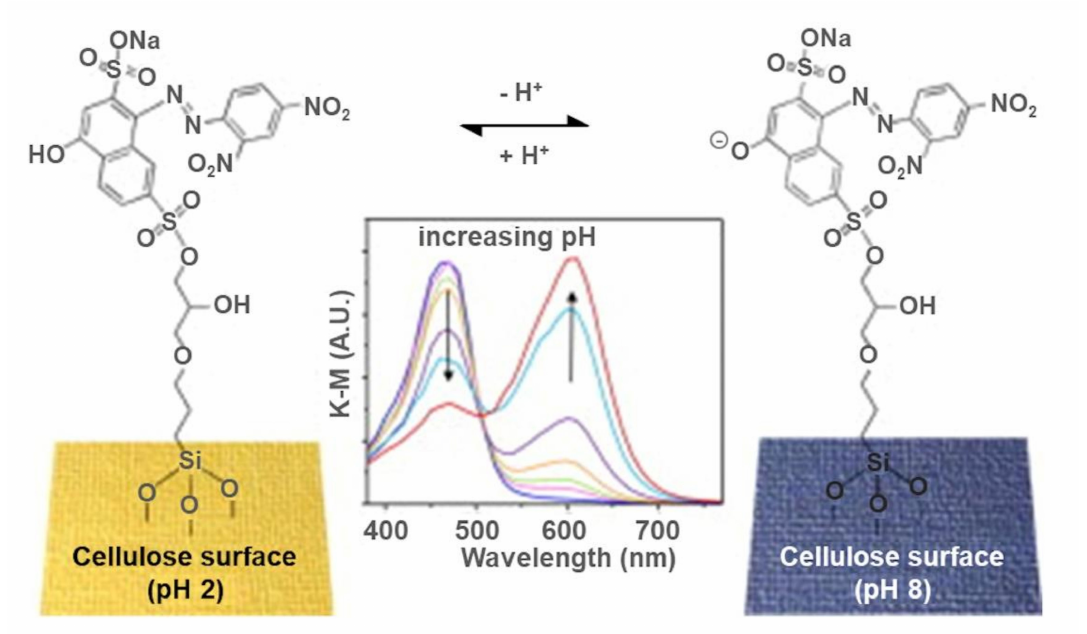
Figure 3. pH sensitive cotton fabrics prepared by covalent immobilization of Nitrazine Yellow (NY) containing hybrid matrix on the textile surface. Reprinted from ref. [111] © 2021 with permission from